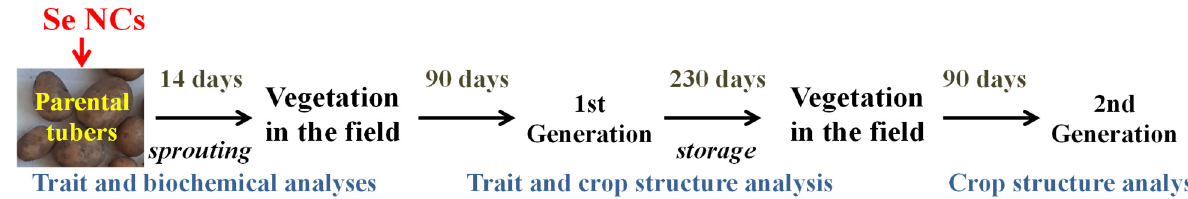
Figure 1. Scheme of the